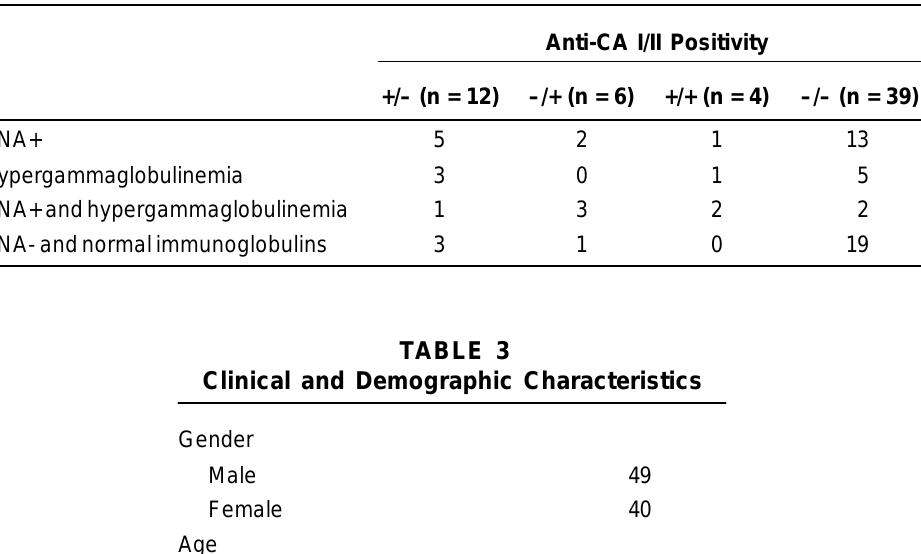
ANA and Hypergammaglobulinemia in